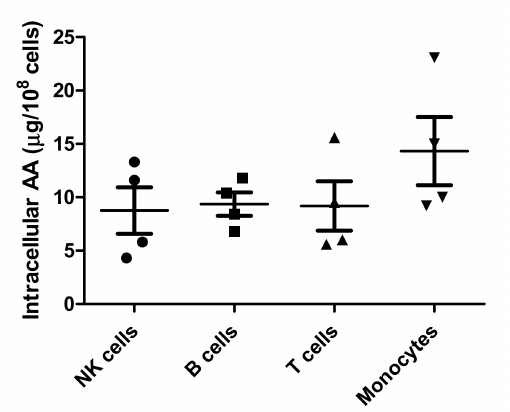
Figure 7. Amount of AA in µ g/10 8 cells for each subset ( n =